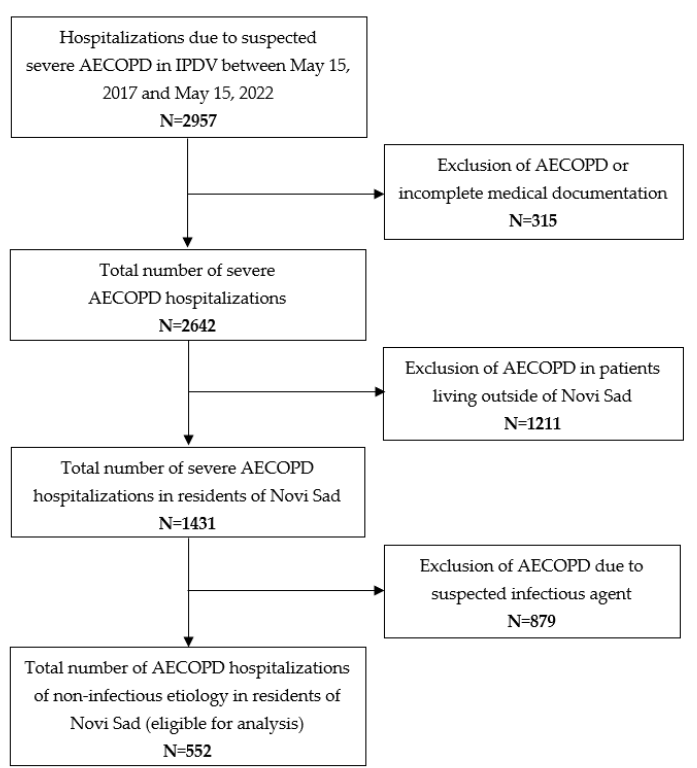
Figure 1. Flowchart of patient sampling.